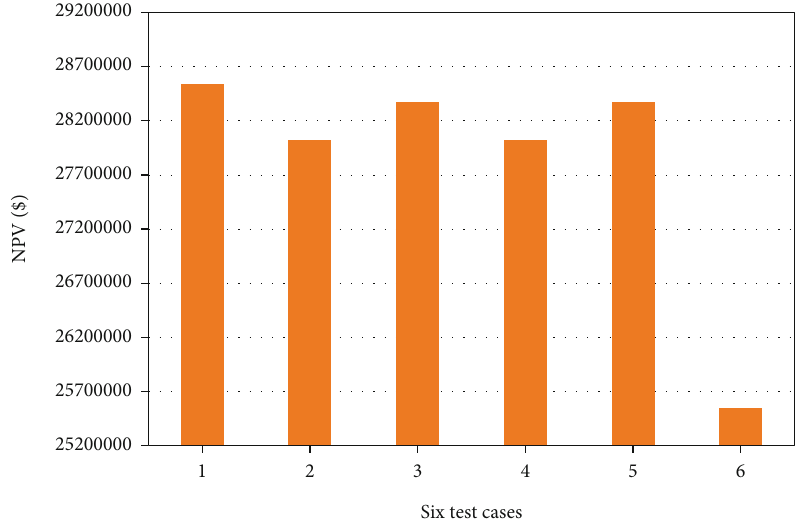
Figure 10: The maximum NPV after 50 iterations for di ff erent